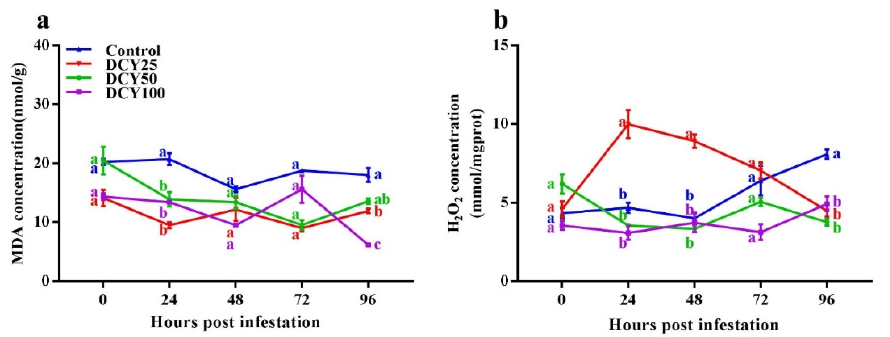
Figure 2. Concentrations of chemical indices in rice leaf sheaths in response to DCY treatment and SBPH infestation. ( a ) MDA, ( b ) H 2 O 2 . Data represent means ± standard error of three replicates. Significant difference between DCY and control plants is indicated by letters (a,b,c) ( p < 0.05, Tukey’s HSD test).